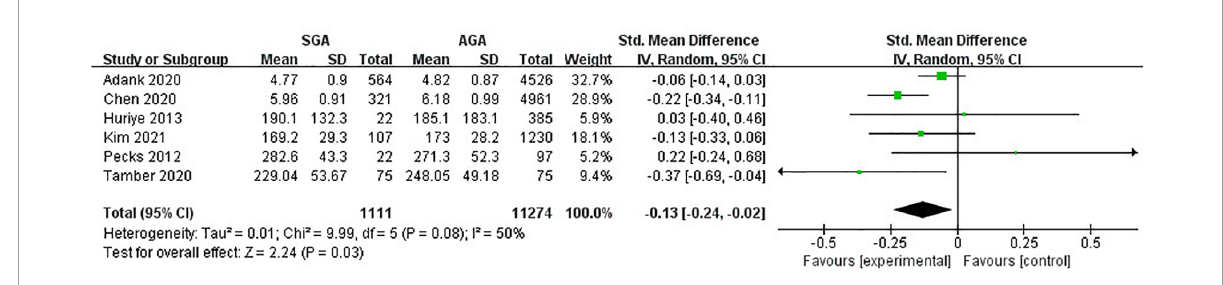
FIGURE2 Forest plot exploring the association between maternal TC levels and delivery of SGA. TC, total cholesterol; SGA, small for gestational age.